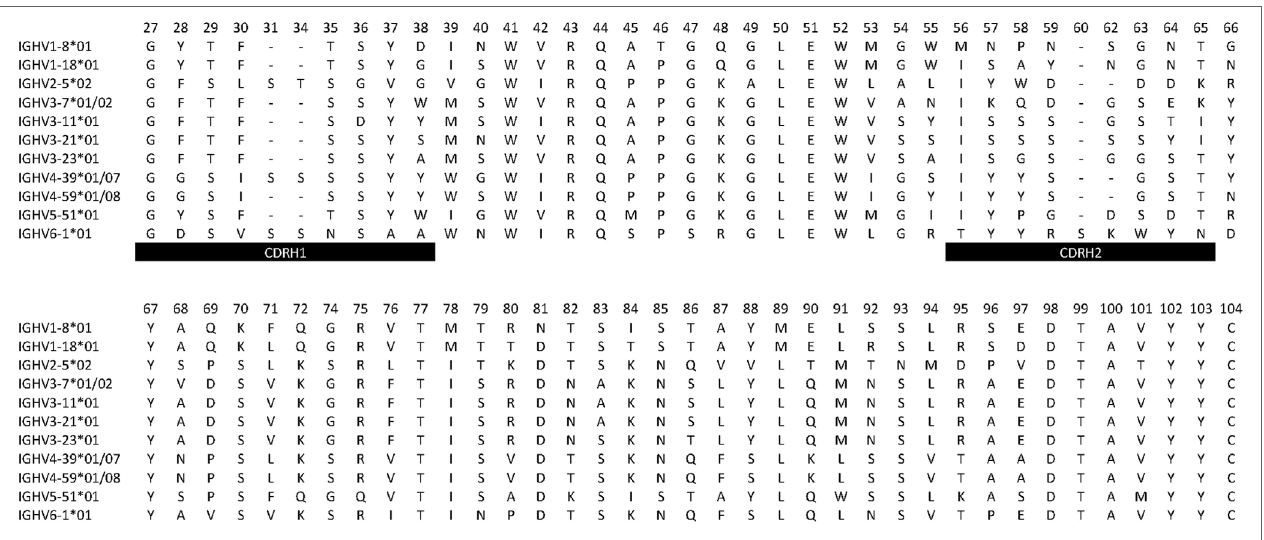
FigUre 1 | Protein sequences (residues 27–104) encoded by germline genes primarily investigated in this study. Boundaries for complementarity determining regions (CDRs) and residue numbering are as defined by the IMGT nomenclature